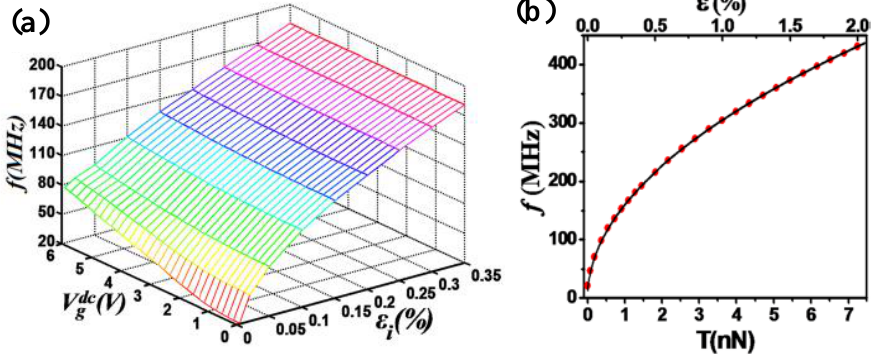
Figure 15. The change of resonant frequency of the CNT as a function of the gate voltage and the axial strain ( a ) and the tension ( b ) reported by Ning et al . Reused with permission from